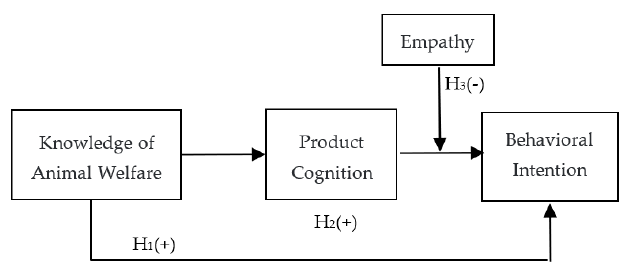
Figure 2. The conceptual framework of animal welfare knowledge, product cognition, empathy, and consumers’ behavioral